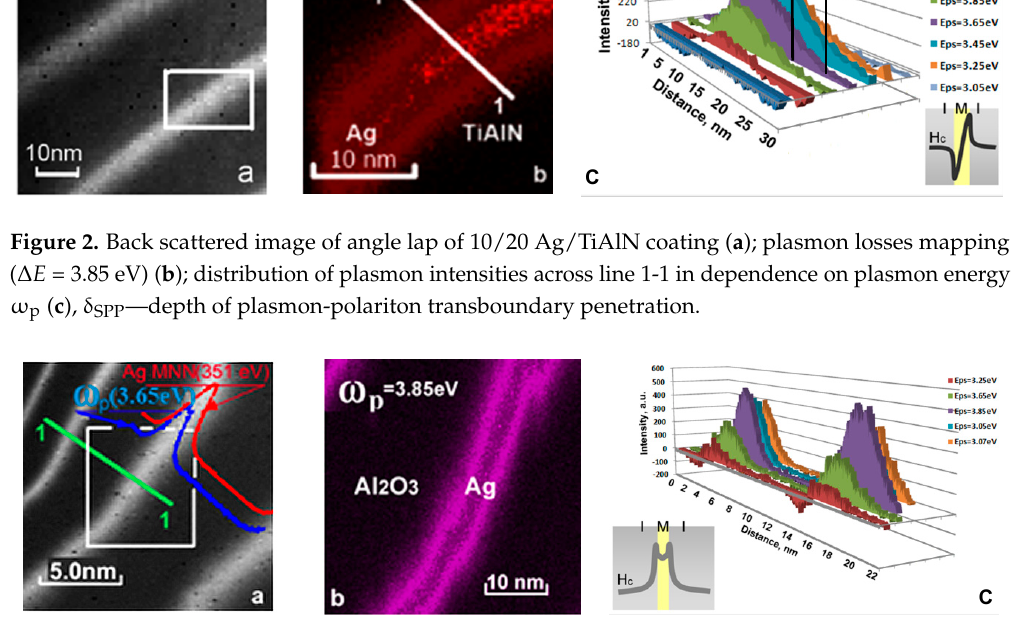
Figure 3. Back scattered image of angle lap of 5/24 Ag/Al 2 O 3 coating ( a ); plasmon losses mapping ( Δ E = 3.85 eV) ( b ); distribution of plasmon intensities across line 1-1 in dependence on plasmon energy ω p ( c ).